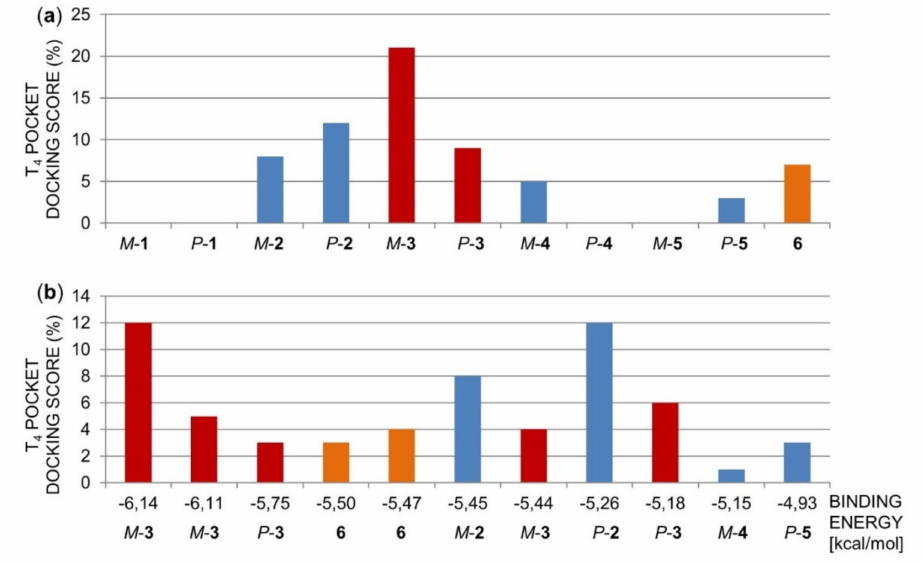
Figure 5. ( a ) Blind docking scores for the enantiomers of compounds 1 – 5 and the achiral 6 in the T 4 pockets; ( b ) docking score and binding energies of each pose of 1 – 6 laying in the T 4